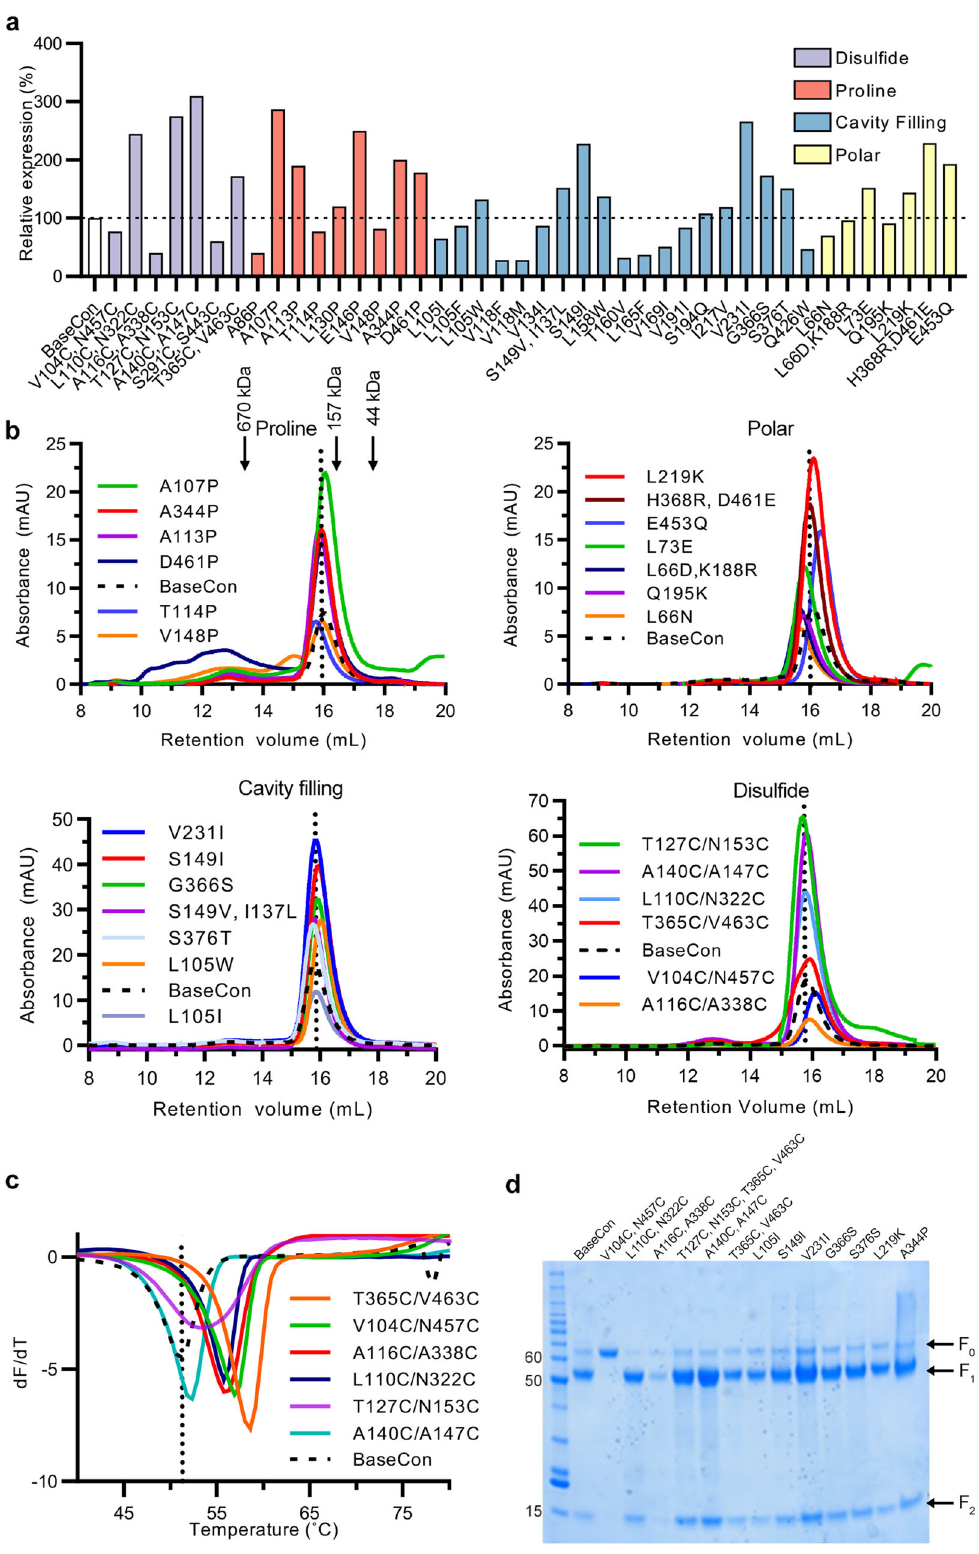
DS-CavEs2 is similar to that of the hMPV F base construct, although it is much weaker than the af fi nity to RSV F DS-Cav1 (Supplementary Fig. 1 and Supplementary Table 2). Taken together, DS-CavEs2 enhances expression by 10-fold and exhibits high thermostability (Tm 71.8 °C) (Fig. 3d), indicating its potential for vaccine